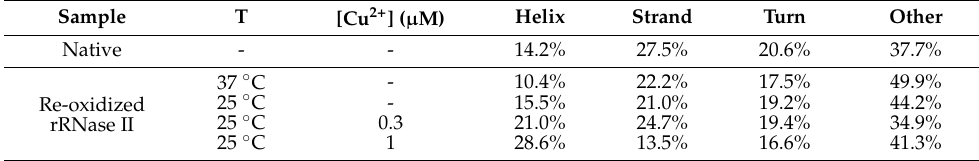
Figure 2. Analyses at different stages of rRNase II (14 µ M) during re-oxidation process in 20 mM Tris-HCl pH 8.5 under different conditions. ( A ) CD spectra of rRNase II at the end of the re-oxidation process. Native RNase (black line), re-oxidized rRNase II at 37 ◦ C (light blue line), and re-oxidized rRNase II at 25 ◦ C (navy blue line). All CD spectra were performed with a protein concentration of 1.25 µ M in 10 mM sodium phosphate buffer pH 7.4, at 25 ◦ C. ( B ) Recovery of activity of re-oxidized rRNase II at 37 ◦ C (light blue column), at 25 ◦ C (navy blue column), and residual activity of re-oxidized rRNase II 2.0 µ M at 30 ◦ C in 50 mM sodium phosphate buffer pH 7.5 with GSH/GSSG (2 mM/0.4 mM) and 5 mM EDTA (grey column). All the activities are compared to the activity of the native protein (black column). Activities were measured as described under Materials and Methods. The error bars represent the S.D. derived from three independent experiments. ( C ) Intrinsic fluorescence emission spectra of native RNase (black line), rRNase II (orange dotted line), re-oxidized rRNase II at 37 ◦ C (light blue line), re-oxidized rRNase II at 25 ◦ C (navy blue line), and re-oxidized rRNase II at 30 ◦ C in 50 mM sodium phosphate buffer pH 7.5 with GSH/GSSG (2 mM/0.4 mM) and 5 mM EDTA (grey line). All the fluorescence emission spectra were recorded with a protein concentration of 1.25 µ M in 10 mM sodium phosphate buffer pH 7.4, 25 ◦ C. Table 3. Secondary structure analysis of the CD spectra of re-oxidized rRNase II.